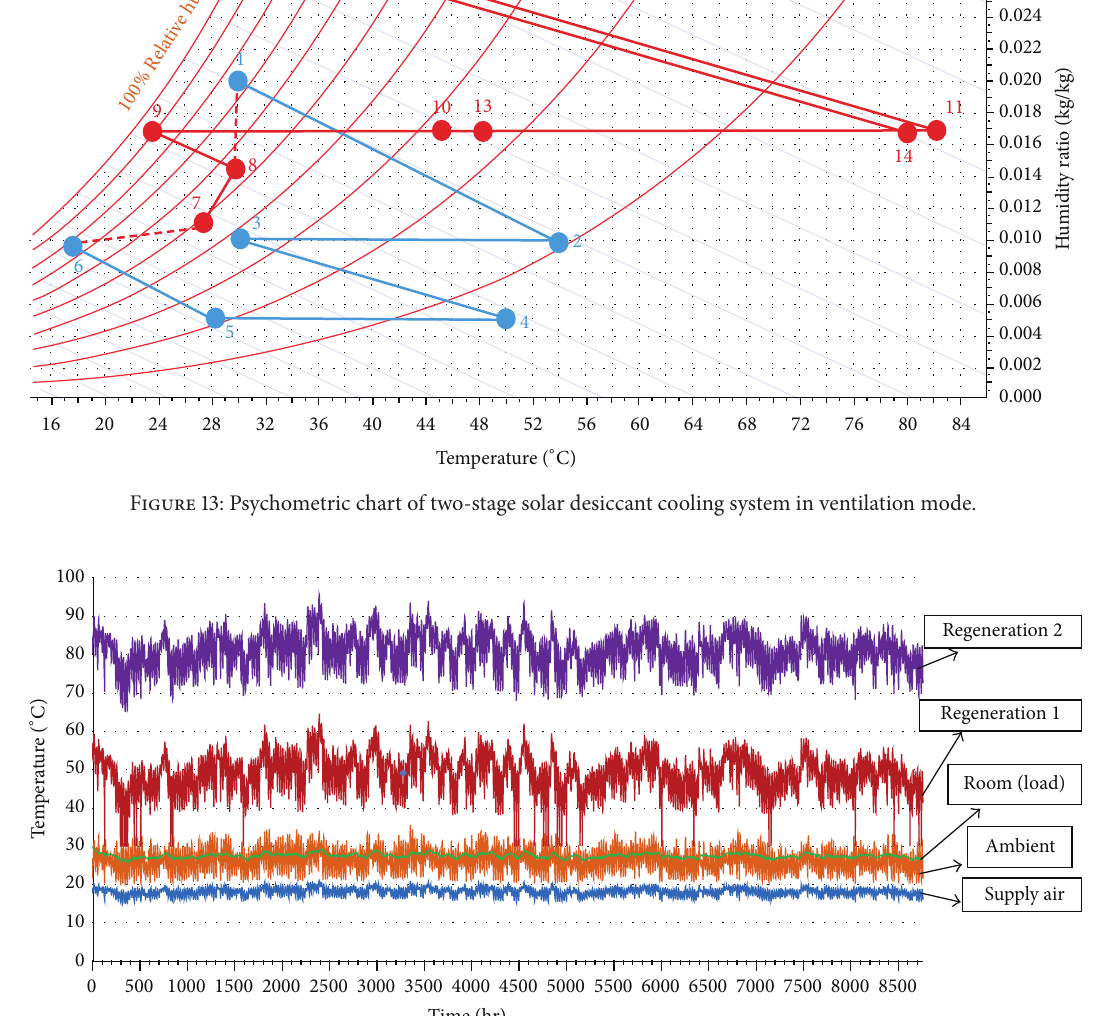
cooling system versus time (hr) is shown in Figure 14. The humidity ratio trend of the various points in the two-stage recirculation system versus time (hr) is shown in Figure